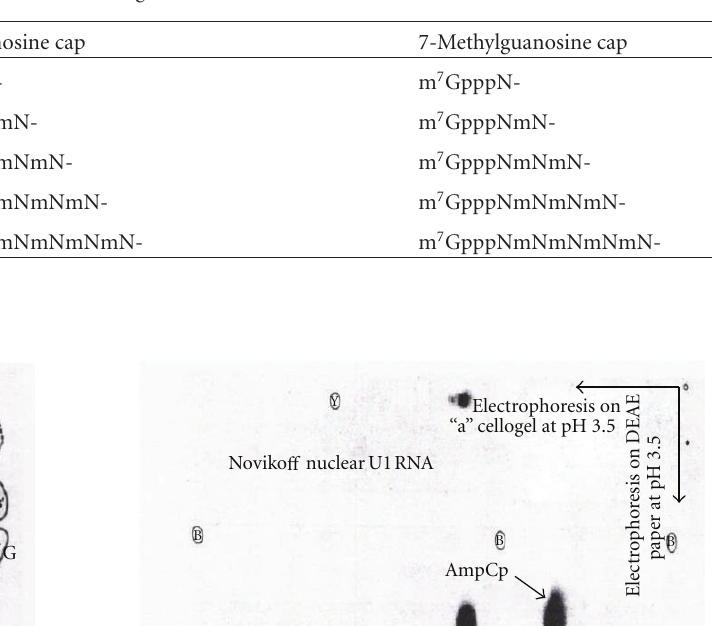
Table 13: Cap variations of flanking nucleotide modifications.